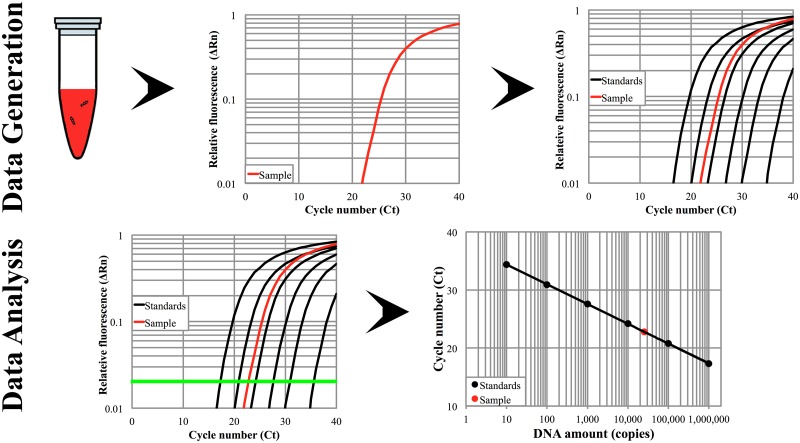
Schematic of qPCR data analysis.Relative fluorescence (ΔRn) was recorded at each PCR cycle for samples and standards of known DNA amounts. A ΔRn threshold value was chosen (green line) in the linear region to determine a Ct value. The Ct value is plotted vs. the amount of input DNA and fit with a regression line. This line was used to back-calculate the initial amount of DNA in an unknown sample by plotting sample on the line with its Ct value.